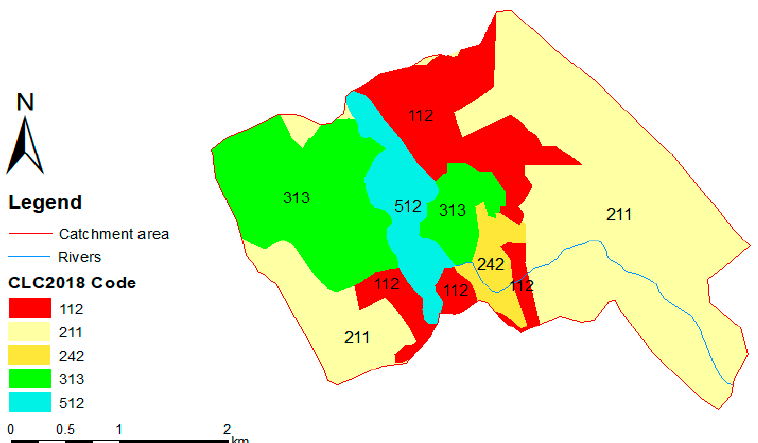
Figure 2. Structure of the land use catchment area of Lake K ó rnickie (112—discontinuous urban fabric; 211—non-irrigated arable land; 242—complex cultivation patterns; 313—mixed forest; 512— water